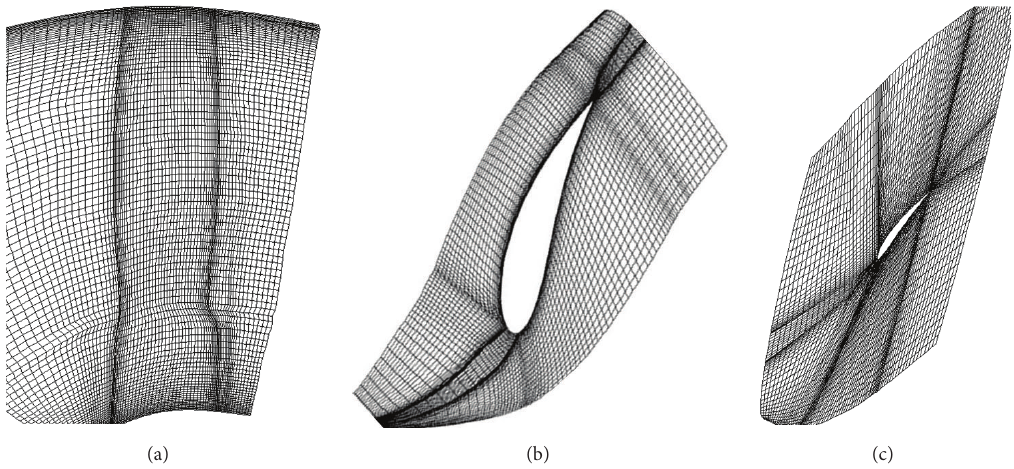
Figure 3: Grids of H type plotted from hub to tip meridional plane (a) and over hub and 𝑅75 planes (b,